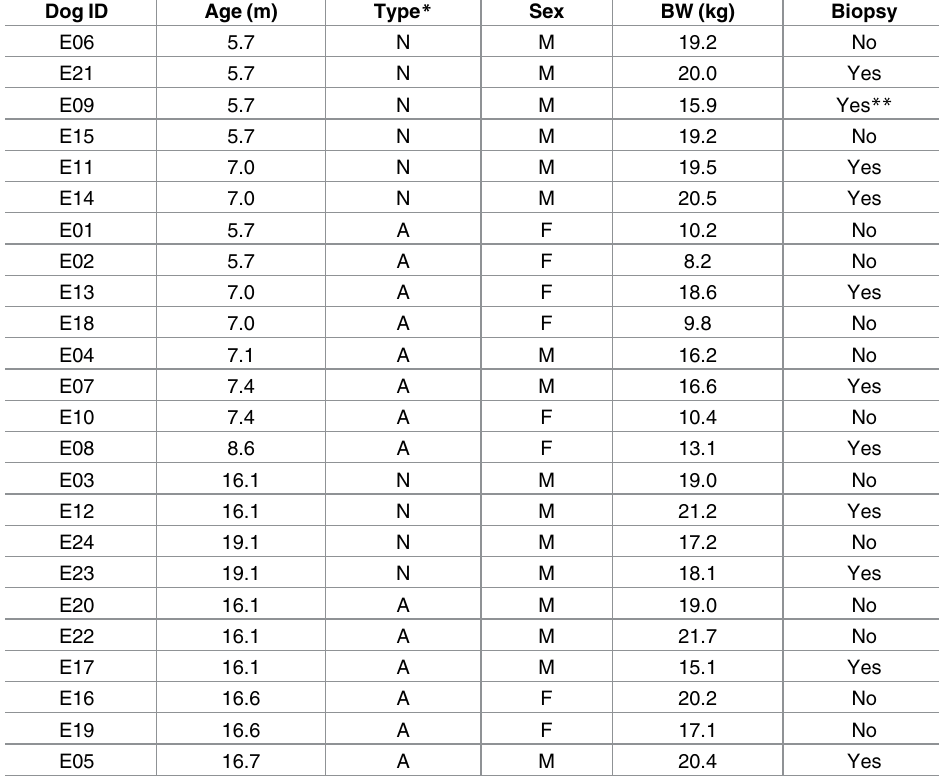
Table 1. Demographic information of experimental